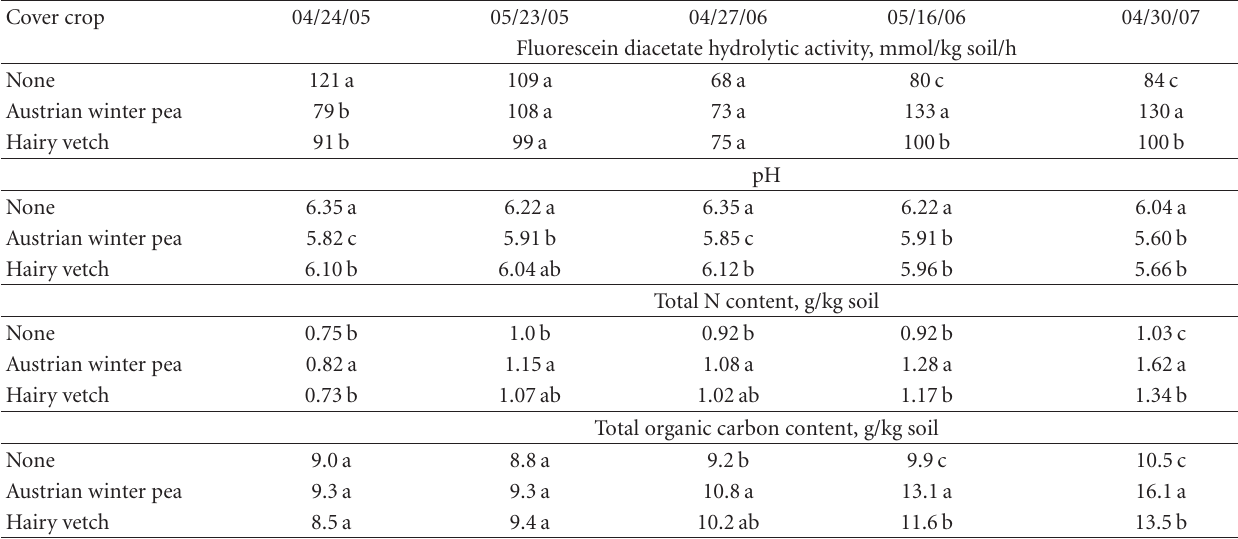
Table 4: E ff ect of Austrian winter pea and hairy vetch on soil properties in 2005–2007.